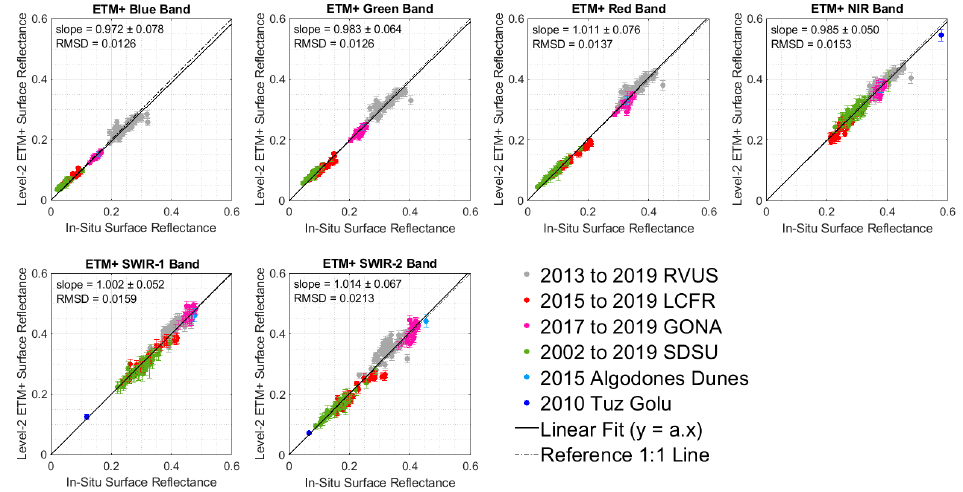
Figure 15. Scatterplots by band of Landsat-7 ETM+ Level-2 surface reflectance data product versus surface reflectance values derived from in situ measurement.